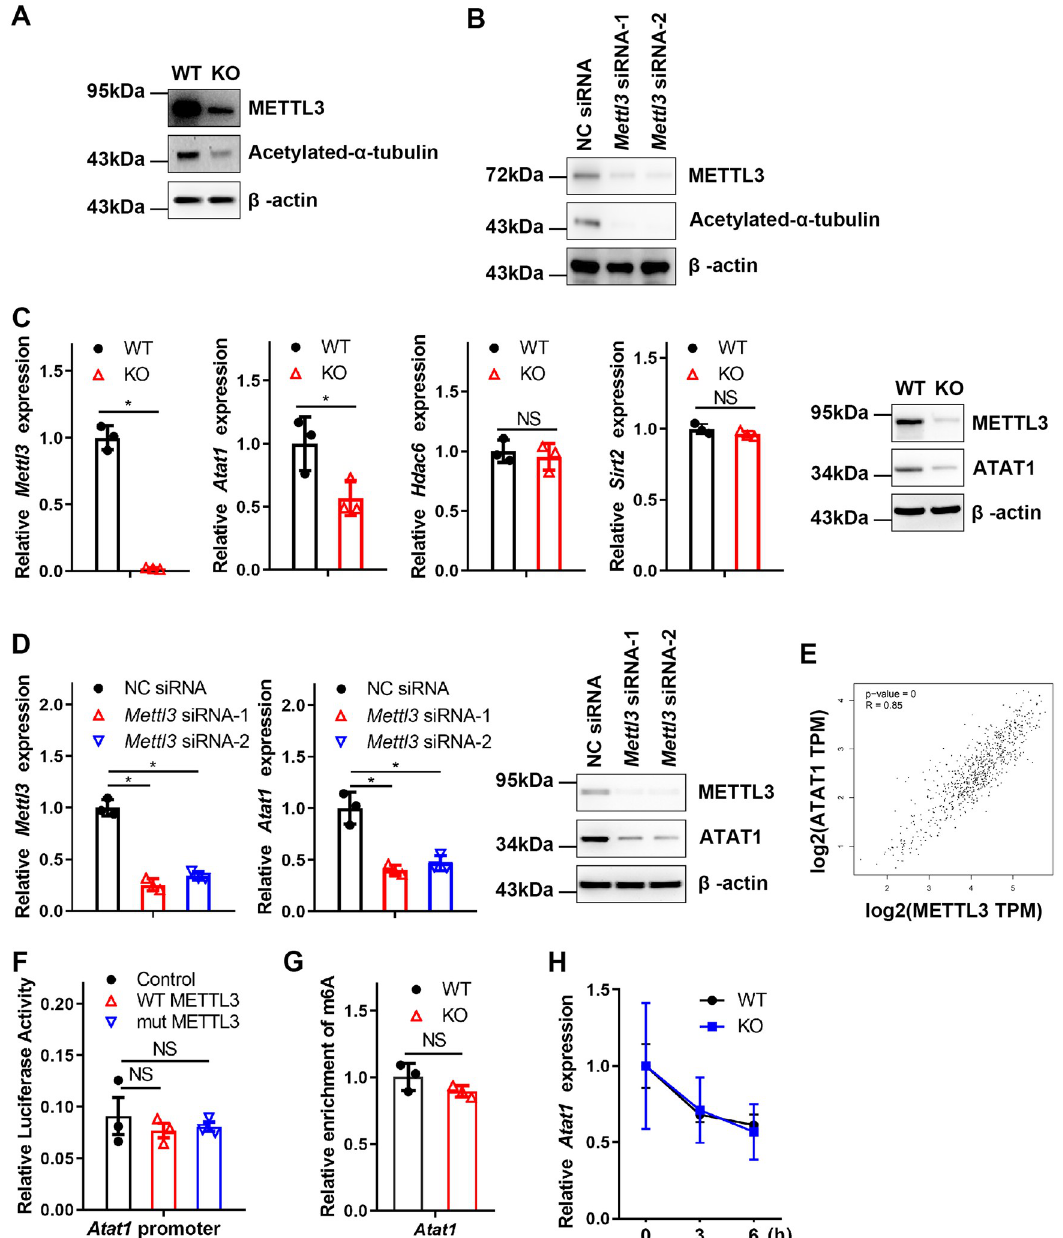
Fig 2. METTL3 enhances ATAT1-mediated microtubule acetylation. (A) Western blotting showing the level of α -tubulin acetylation in WT and KO BMDMs. (B) Immunoblotting analysis of the indicated proteins in the BMDMs transfected with NC siRNA or Mettl3 siRNA. (C) Expression of Mettl3 , Atat1 , Hdac6 , and Sirt2 in WT and KO BMDMs evaluated by qRT-PCR. The expression of ATAT1 was measured by immunoblotting. (D) qRT-PCR and immunoblotting analysis of Mettl3 and Atat1 expression in BMDMs transfected with NC siRNA or Mettl3 siRNA. (E) Bioinformatics analysis showed the expression levels of METTL3 and ATAT1 in normal tissue through the GEPIA database. (F) Cells cotransfected with a luciferase reporter construct of the ATAT1 promoter (2 kb) and wild-type or mut METTL3. The results are shown as firefly luciferase activity normalized to Renilla luciferase activity. (G) MeRIP-qPCR analysis of Atat1 expression in the WT and KO BMDMs. (H) Atat1 mRNA decay assay in the WT and KO BMDMs treated with actinomycin D. All data in the figure are shown as the mean ± SD. P < 0.05 ( � ). NS means no significant difference. Underlying data can be found in S1 Data. BMDM, bone marrow-derived macrophage; KO, knockout; MeRIP- qPCR, methylated RNA immunoprecipitation-qPCR; NC, negative control; qRT-PCR, quantitative reverse transcription PCR; WT, wild type.